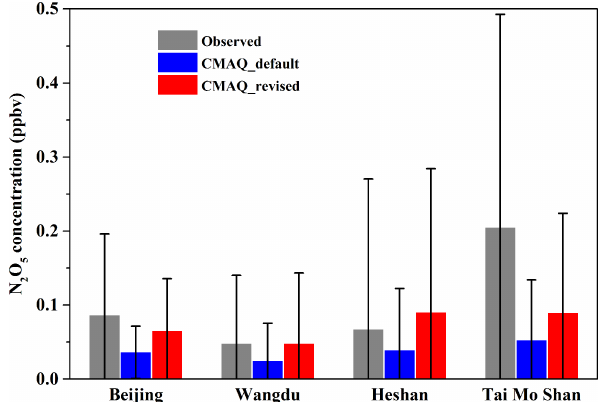
Figure 6. Comparison of simulated N 2 O 5 concentrations by the CMAQ model for December 2017 with the wintertime observation results from four sites in China. The field observations were con- ducted in Wangdu (Hebei Province) in December 2017, Beijing in January 2018, Heshan (Guangdong Province) in January 2017, and Tai Mo Shan (Hong Kong) in November 2013. The columns and error bars represent the average value and standard deviation, re-